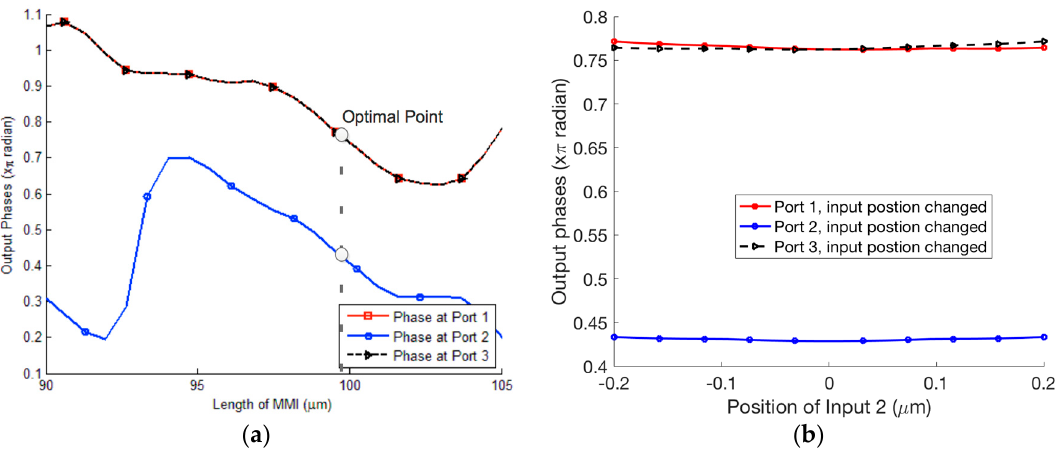
Figure 3. The sensitivity of phases in output ports to ( a ) MMI (multimode interference) length and ( b ) position of input 2.